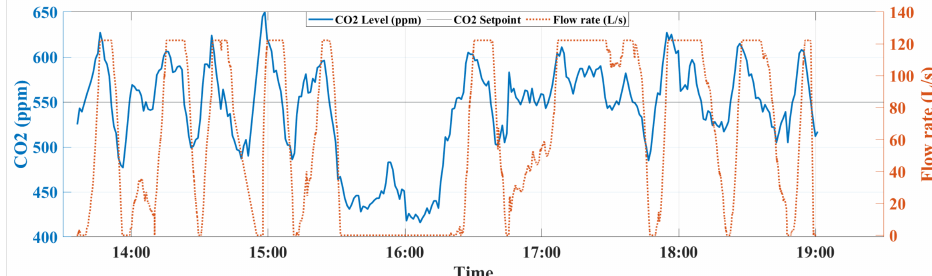
Figure 12. The MPC flow rate output together with the CO 2 concentration variation.